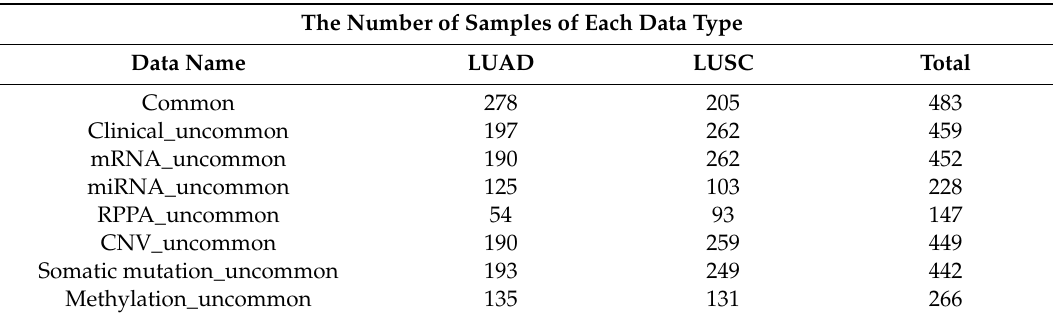
Table 1. The summary of common and uncommon data